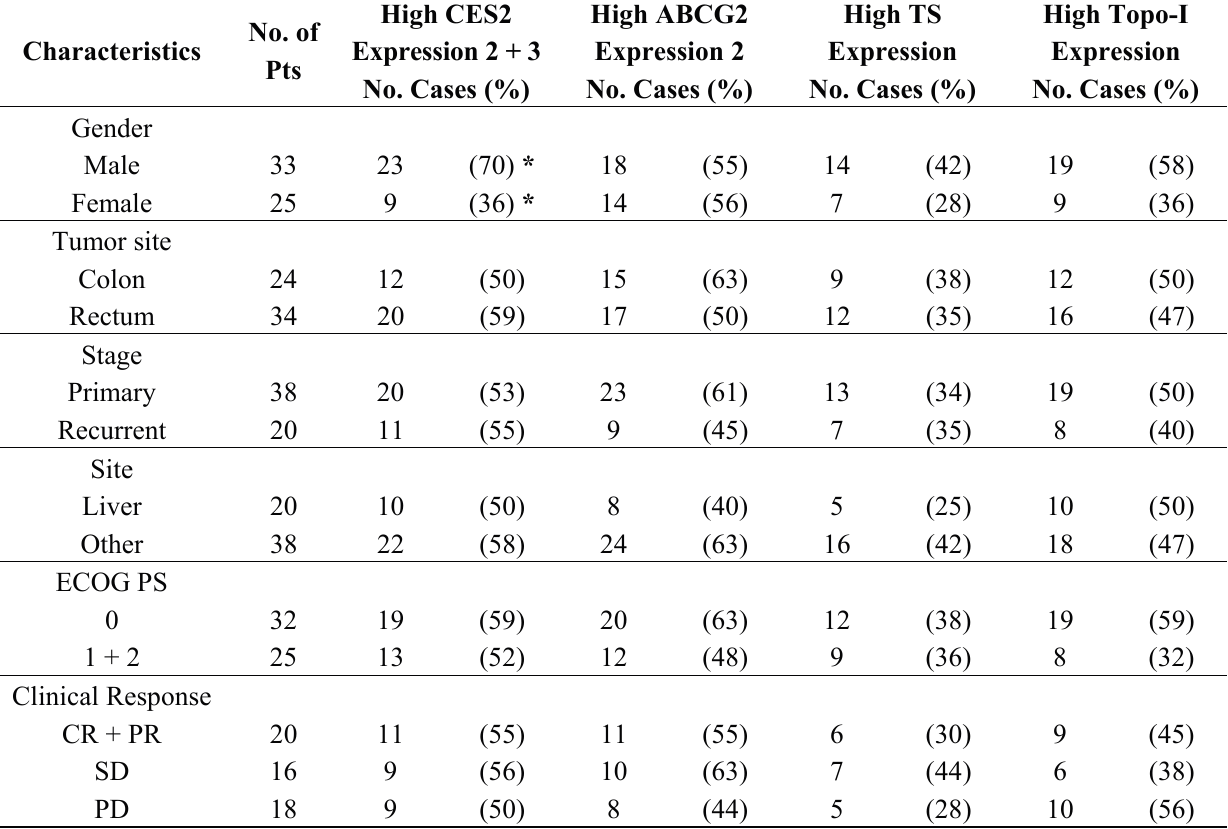
Table 1. Patients with high biomarker expression in relation to clinicopathological characteristics.